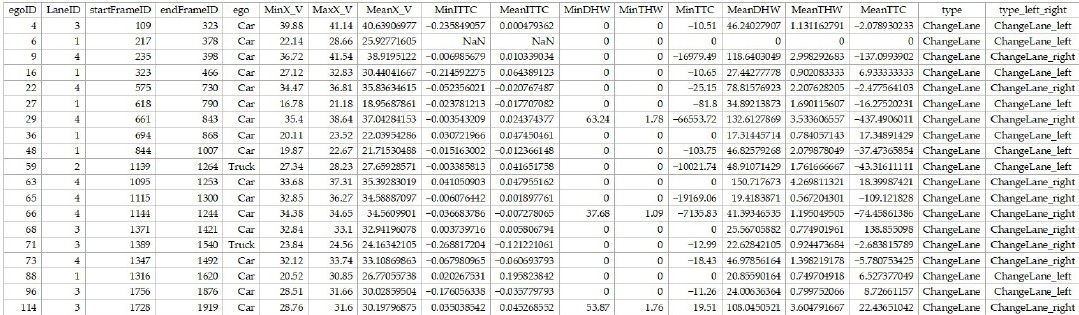
Figure 5. The extracted partial lane-changing data.